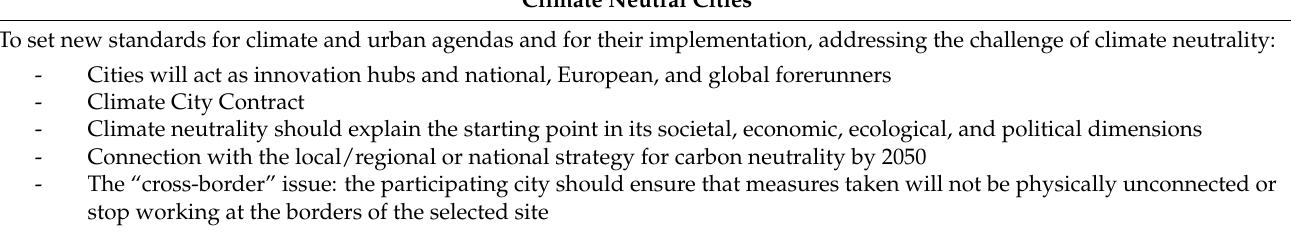
Table 7. The Climate-Neutral Cities